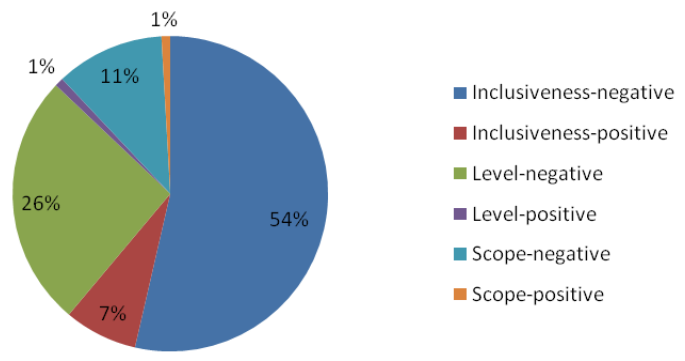
Figure 2. Current EU set-up (n = 332).